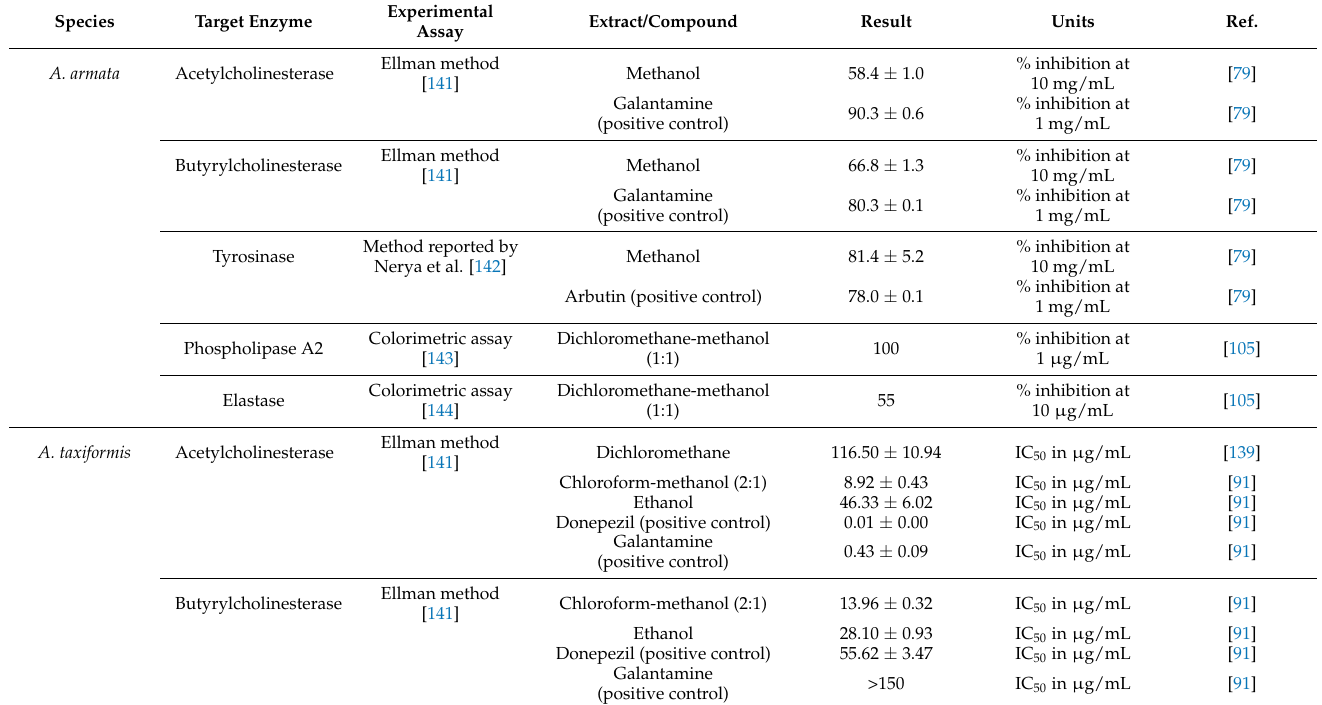
Table 5. Enzyme inhibition activity of Asparagopsis